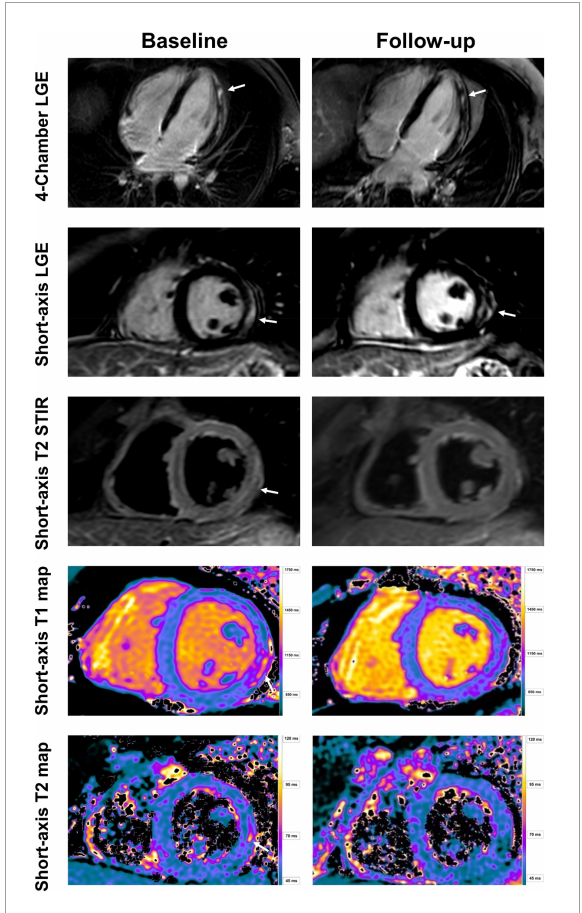
FIGURE2 Baseline and follow-up cardiac imaging in a 25-year-old male with acute vaccine associated myocarditis after receiving his second vaccine with Pfizer/BioNTech. Short-axis and 4-chamber late gadolinium enhancement (LGE) views demonstrate subepicardial enhancement along the midventricular and apical inferolateral wall (arrows). T2 short-axis short tau inversion recovery (STIR) imaging corresponding to the LGE findings shows a resolution of edema from baseline to follow-up (arrow). Normalization of T1 and T2 relaxation times are also demonstrated over time (arrow). Note, however, the persistent LGE along the inferolateral wall even at follow-up, consistent with scar